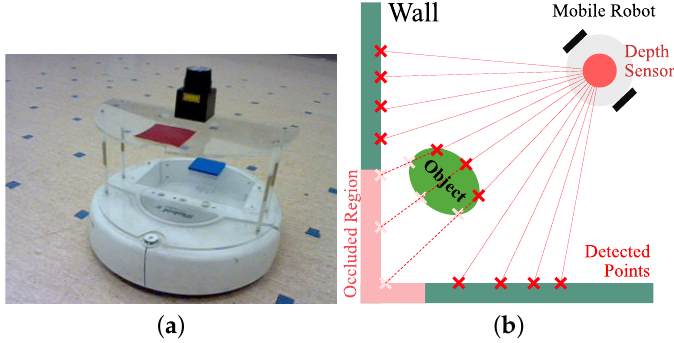
Figure 1. Mobile robot and sensor reading example ( a ) a mobile robot Roomba robot mounted with a laser sensor as the depth sensor; ( b ) an example of sensor readings with the laser sensor (red x marks show the distance readings for given